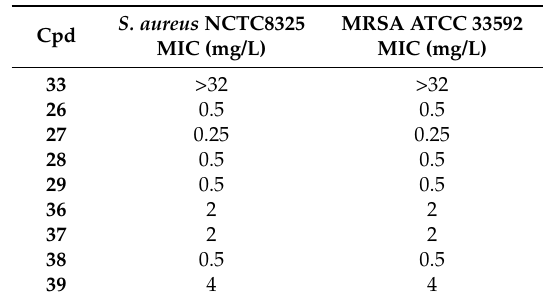
Table 4. Comparison of antibacterial activity of test agents against S. aureus NCTC8325 and MRSA ATCC33592.